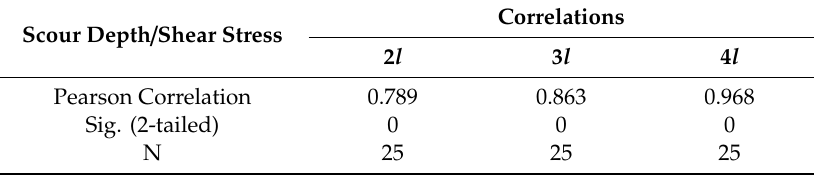
Figure 10. The relationship curve of scour depth and shear stress. ( a ) for 2 l spacing; ( b ) for 3 l spacing; ( c ) for 4 l spacing. Table 4. The scour depth and shear stress